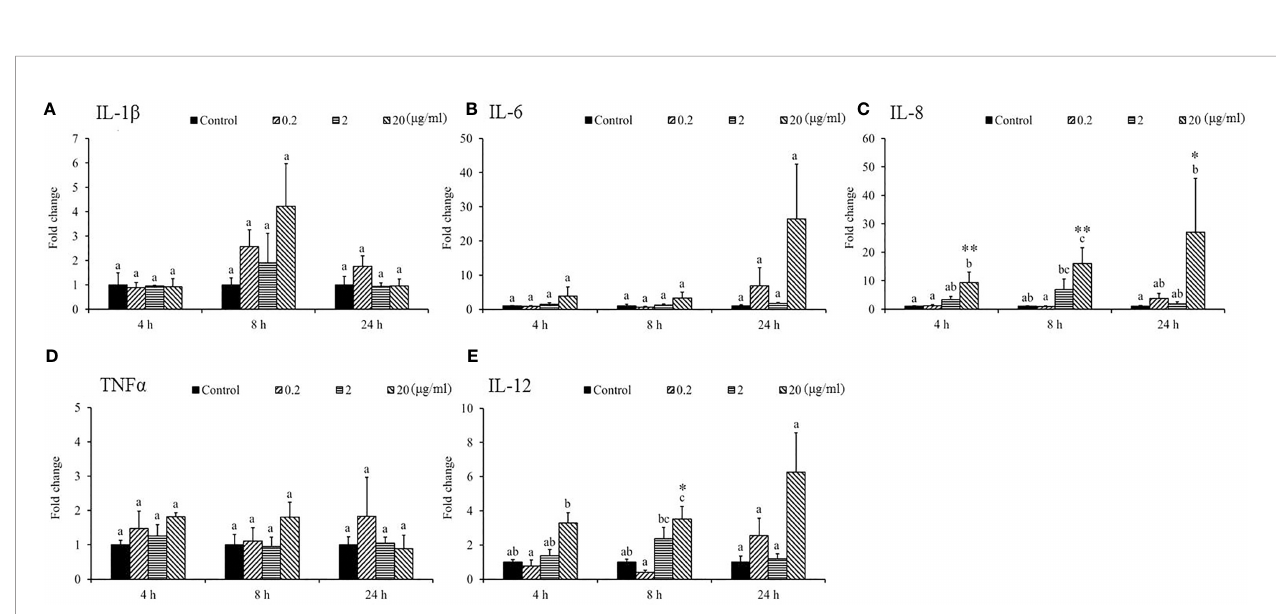
FIGURE 2 | Expression of cytokine genes in the head kidney (HK) tissue from Sarcodia suiae water extract (SSWE) treated cobia. Fish injected intraperitoneally with PBS (Control) or SSWE were sampled and the expression of (A) IL-1 b , (B) IL-6 , (C) IL-8 , (D) TNF a , and (E) IL-12 in the HK samples was analyzed. The values are shown as mean + SEM (N = 3). Signi fi cant differences between samples and their time matched control group are shown with asterisks (* p < 0.05 and ** p < 0.01 ) and differences between groups are indicated by different letters.